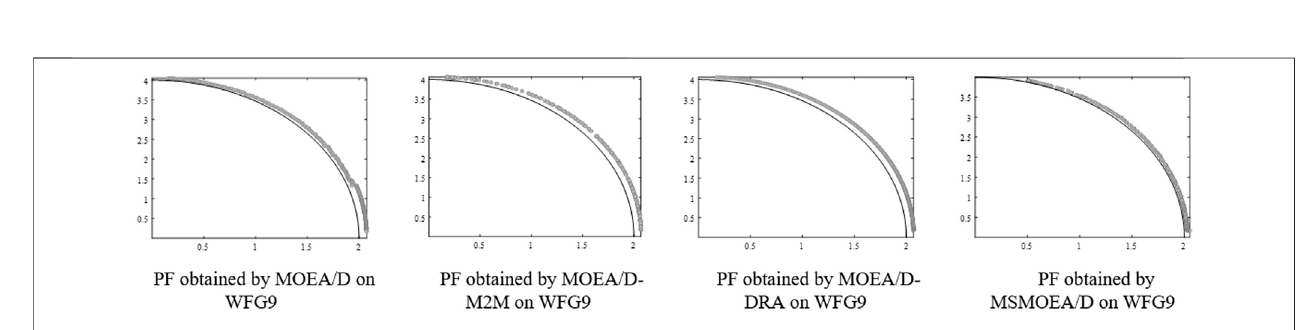
Frontiers in Energy Research |